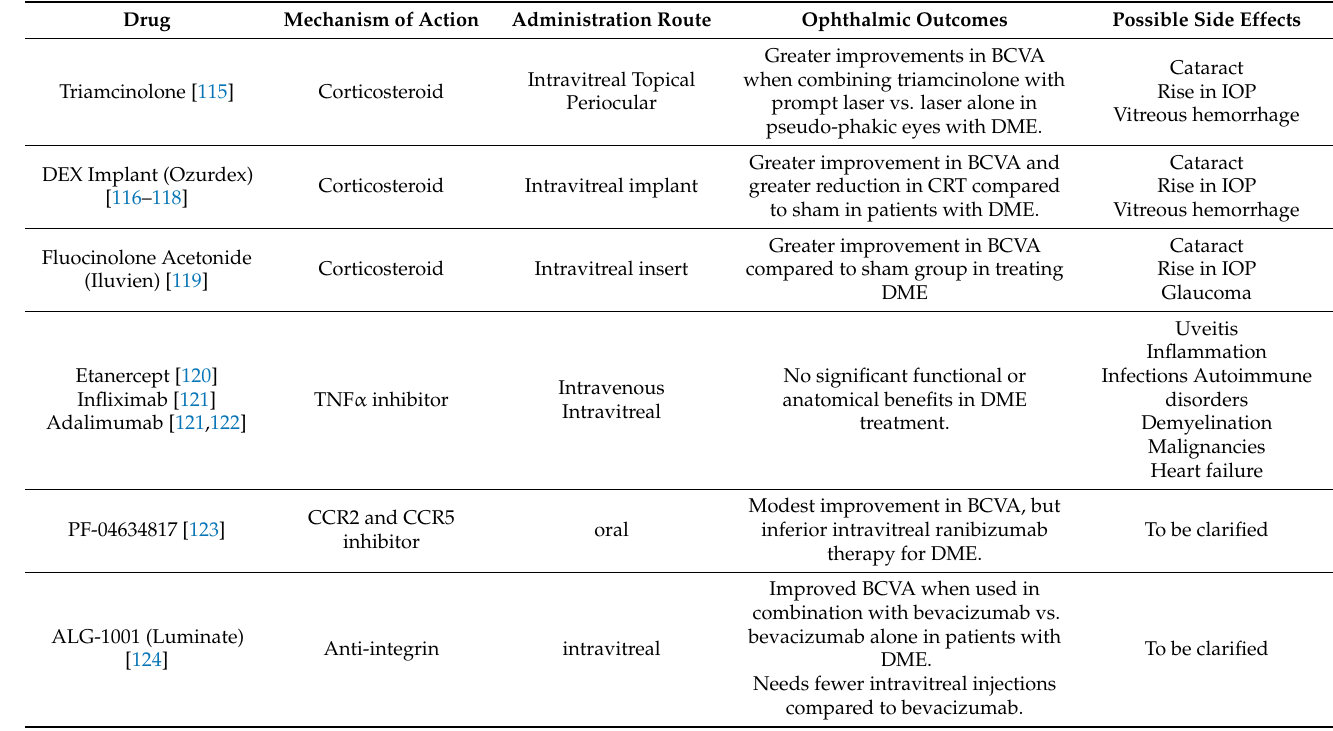
Table 2. Anti-inflammatory agents for the treatment of